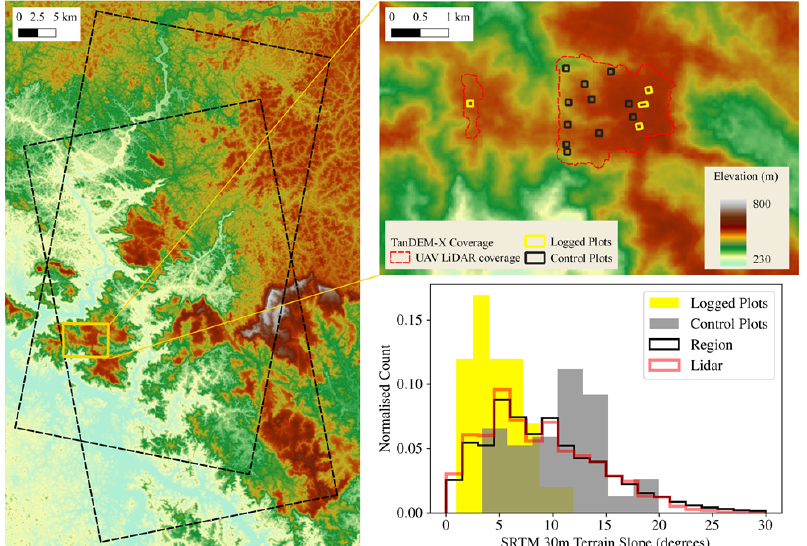
Figure 3. Elevation and slope statistics of the study site, according to 1 arc-second SRTM data. ( Left ) Elevation over the area covered by ascending and descending TDX acquisitions (dashed black rectangles). ( Upper Right ) Elevation over the area covered by UAV laser scanning (red dashed line) and containing our 1 ha plots (black and yellow rectanges). ( Lower Right ) Histograms of slope steepness for the TDX footprints, UAV Lidar coverage and field